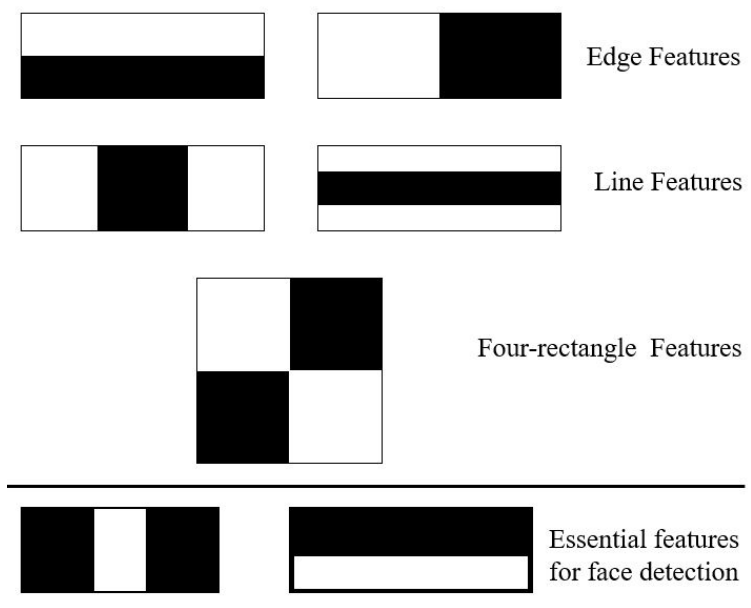
Figure 5. Haar-like